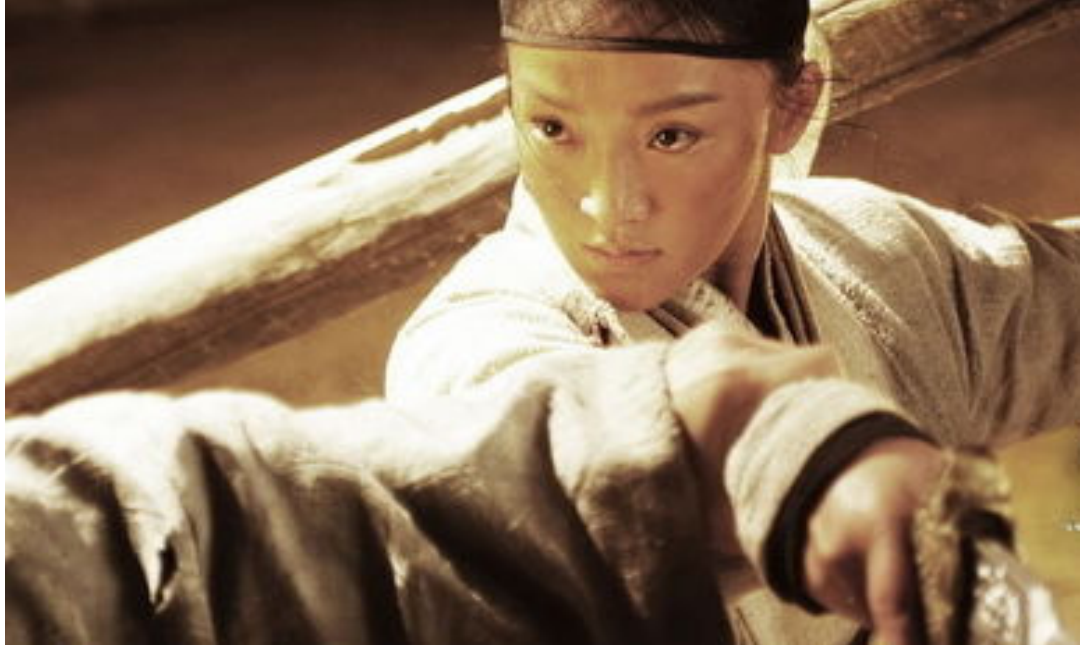
Figure 3. Ling Yanqiu dressed in masculine